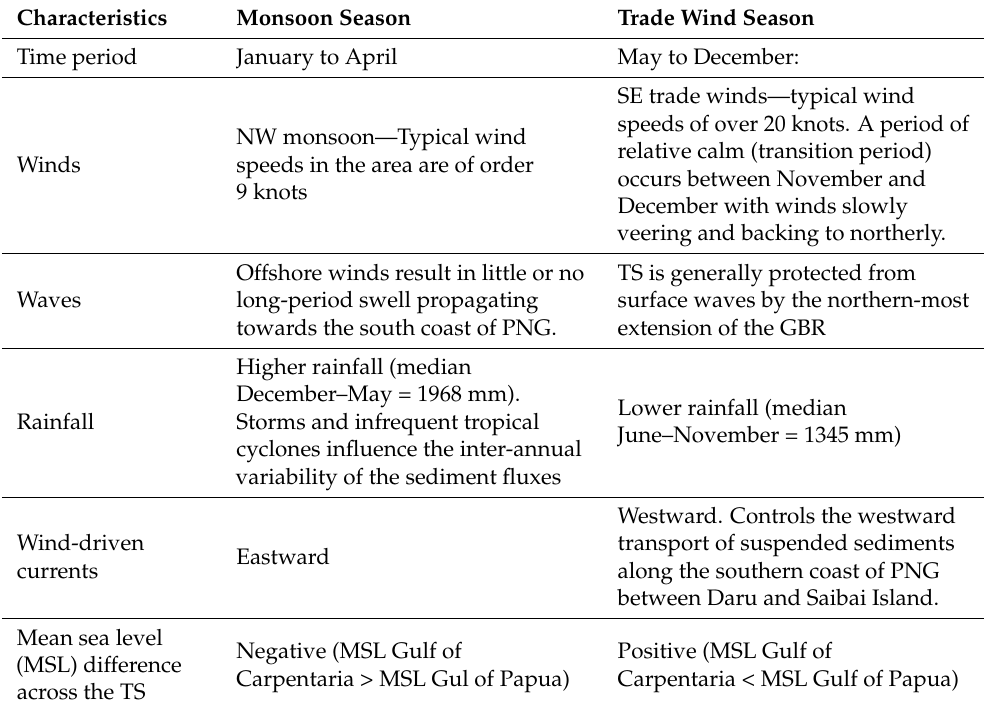
Table 1. Summary of the METocean and hydrodynamic characteristics of the PNG region [23,38,39,41,43,63].